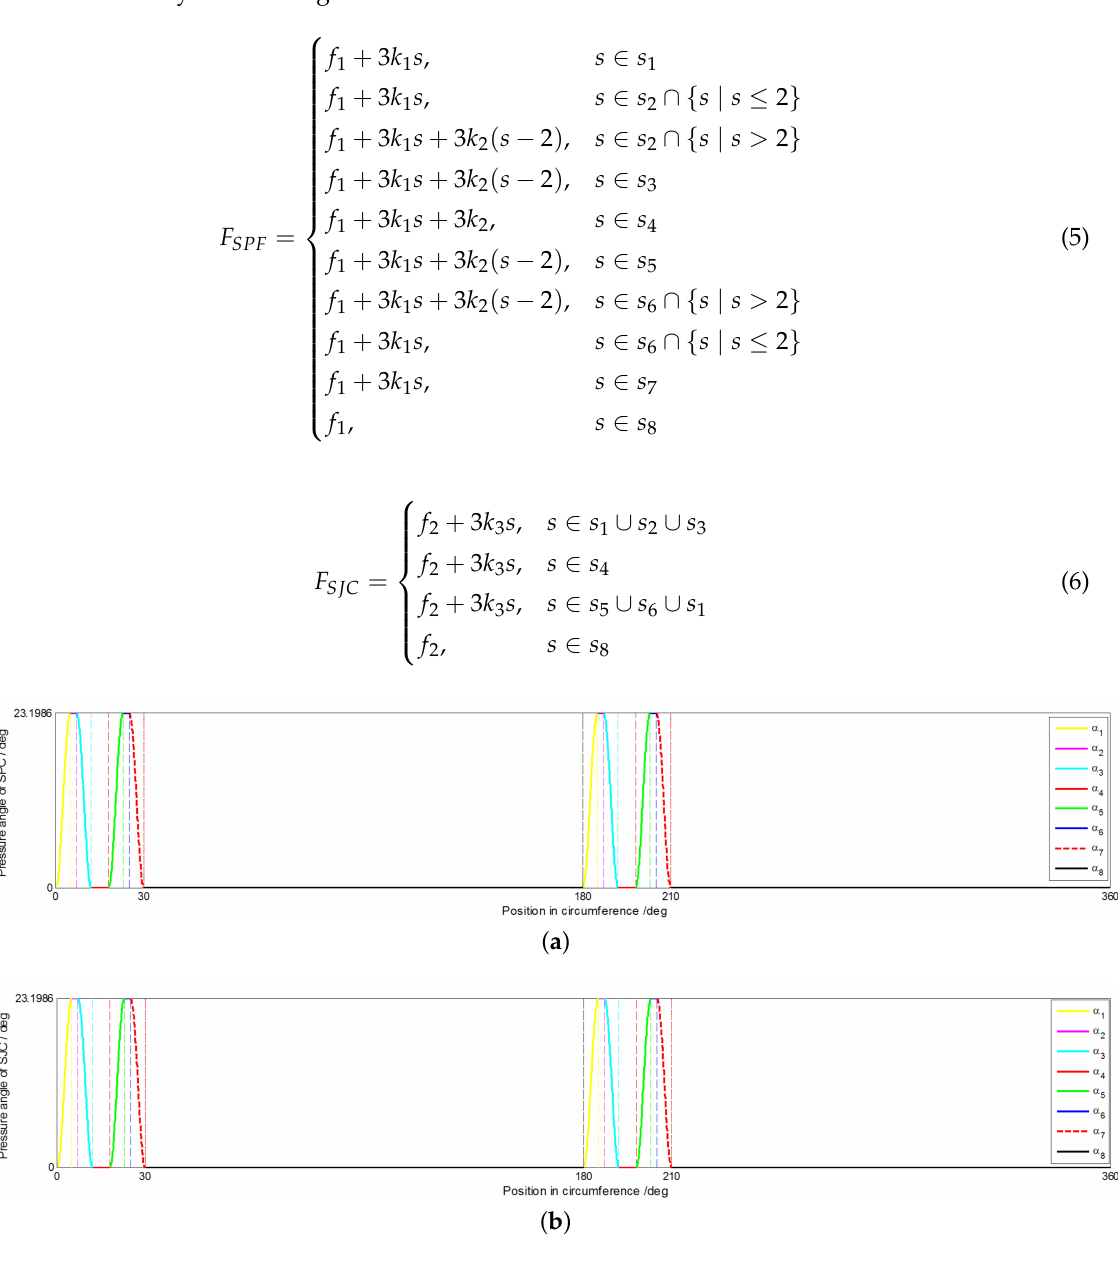
Figure 9. The pressure angle curves of SPC and SJF. ( a )The pressure angle between SPF for SPC. ( b ) The pressure angle between SJF for